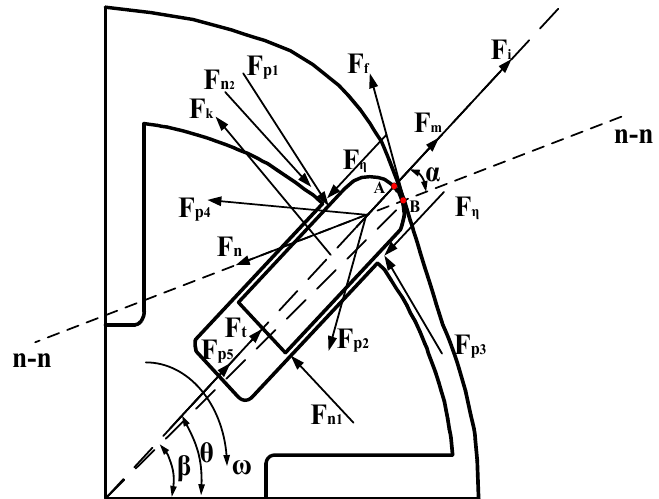
Figure 3. Blade transition cavity force analysis diagram.